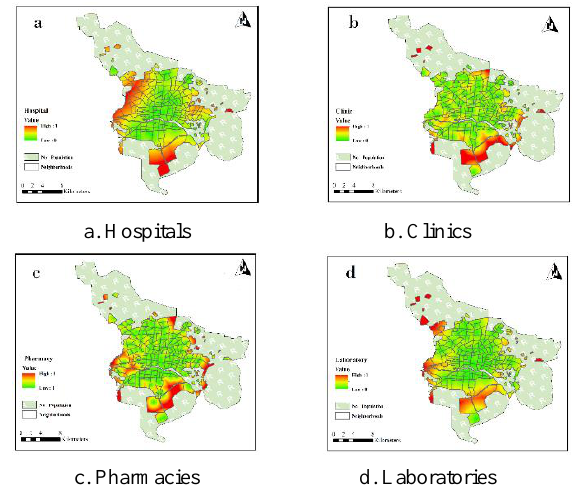
Figure 5 . The maps of distance to the nearest healthcare